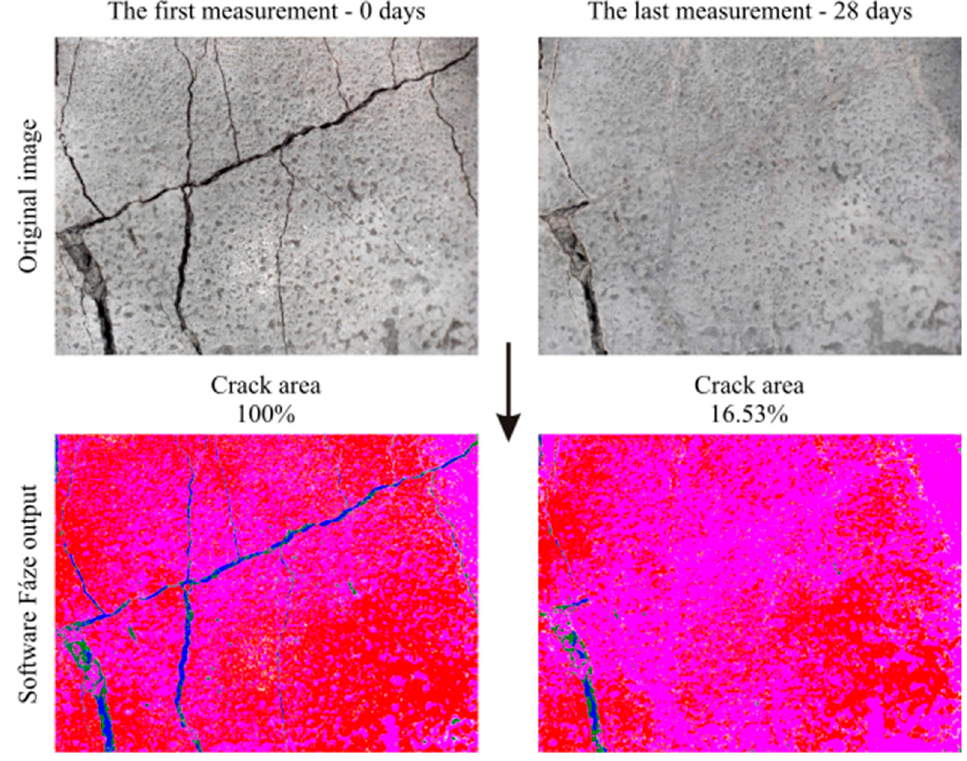
Figure 9. Development of the crack area.